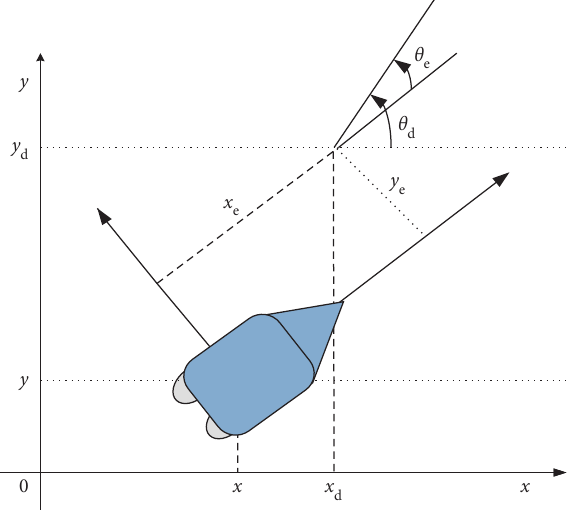
Figure 3: Control system modeling for trajectory-tracking